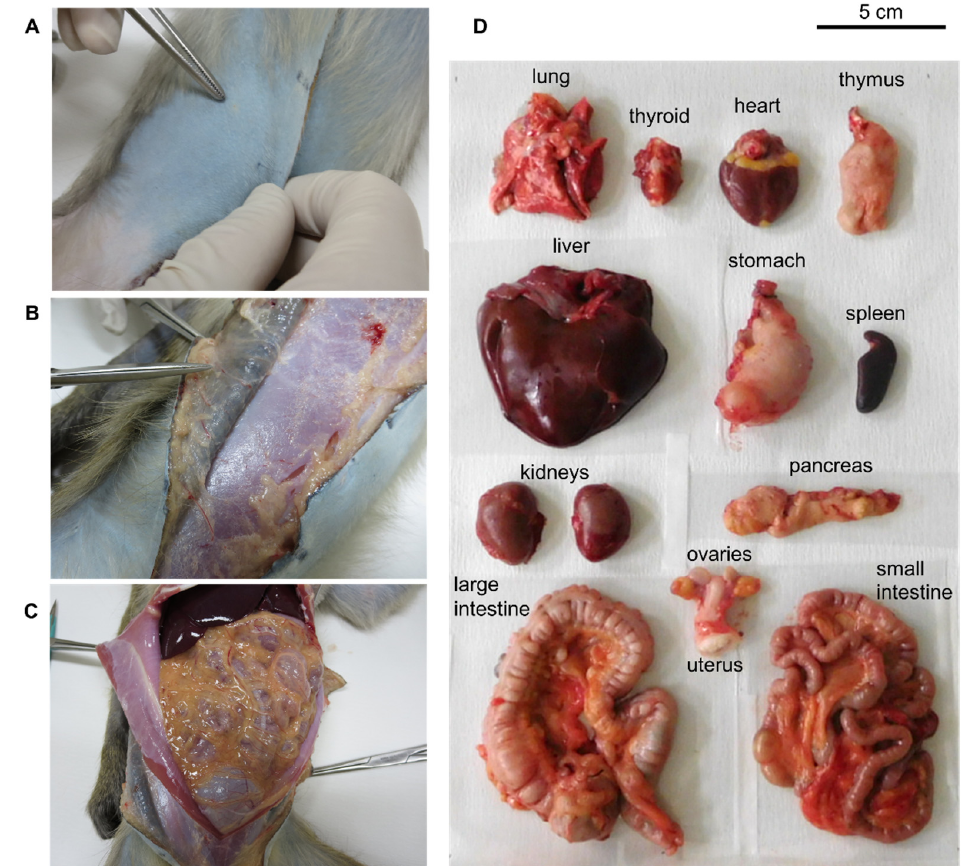
Figure 4. Local irritation and autopsy examination of animals after the intraperitoneal administration of 64 Cu-NCAB001. ( A ) Surface of the abdominal skin, ( B ) surface of the abdominal muscle, and ( C ) outer surface of the peritoneum containing the administration site. ( D ) Organs excised from the body. Administration-related abnormalities were not found in any organs.